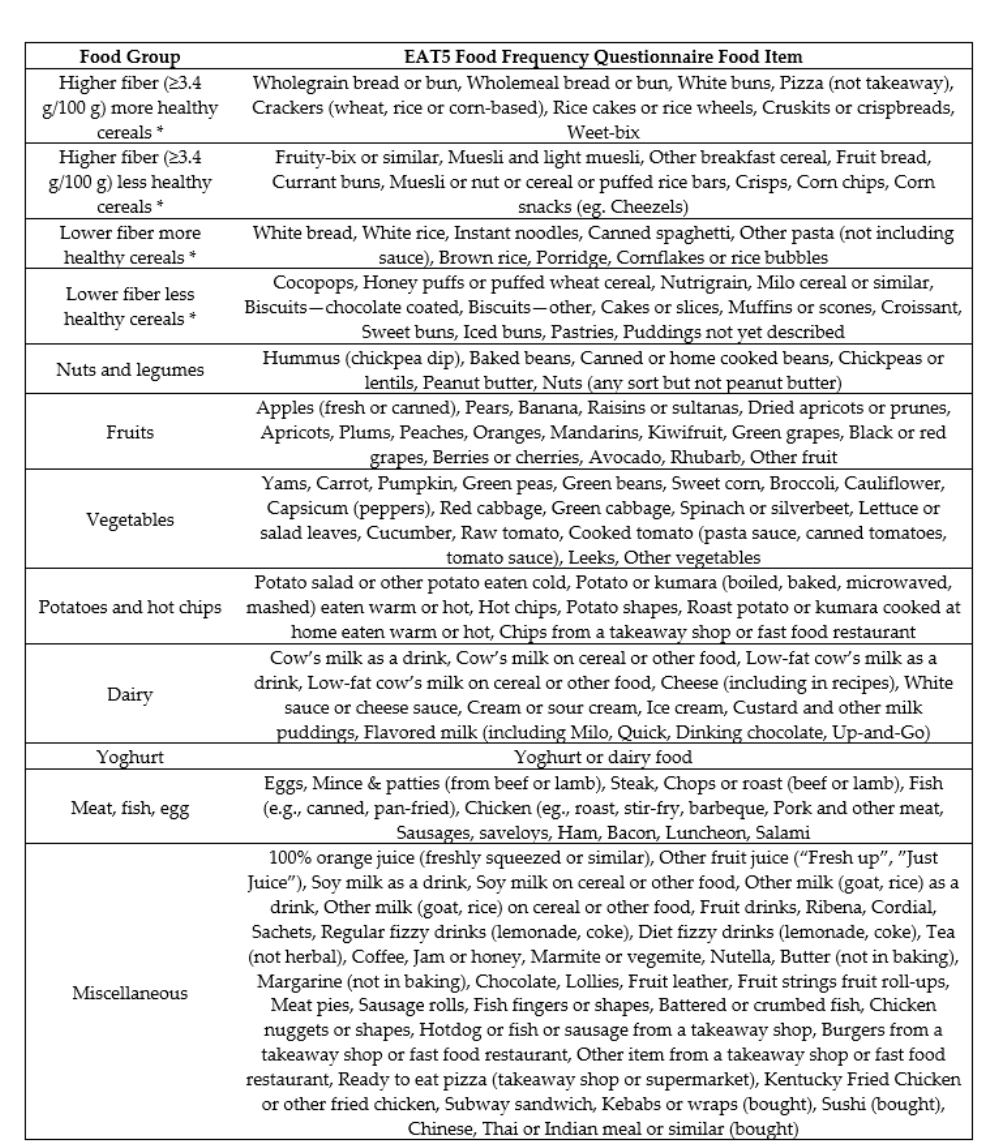
Figure 1. Food groups developed based on their relevance to the gut microbiota. Note: * ‘Higher fiber’ was defined as ≥ 3.4 g of dietary fiber which was the median fiber content of the 1010 individual food items reported in the weighed diet records ; ‘More healthy’ was defined as ‘staple foods’ with a lower saturated fat and sugar (<15 g/100 g) content.